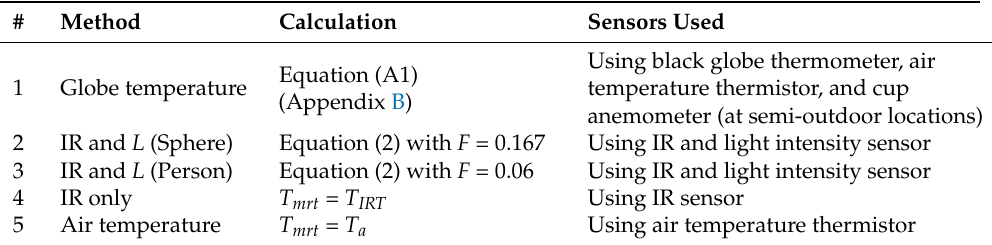
Different calculation methods for mean radiant temperature ( T mrt ) tested on the MoBiMet